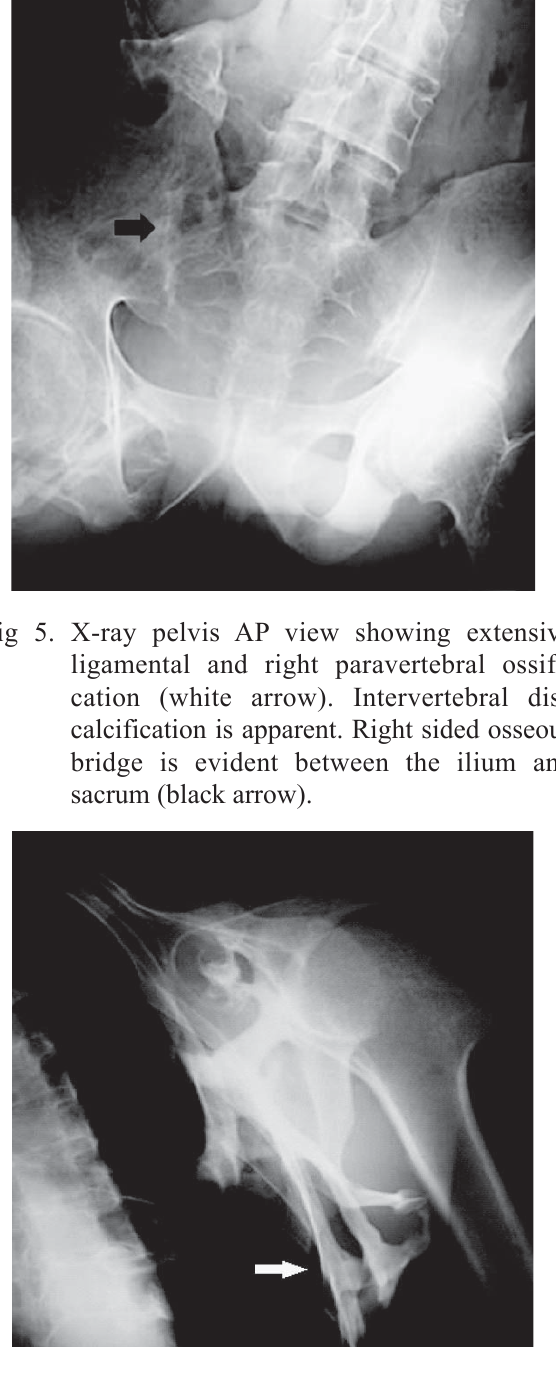
Fig 4. X-ray dorsal spine AP view showing scoliosis with convexity towards left. Orthotopic fusion of dorsal vertebra is seen. Pseudoexostoses with soft tissue ossification is evident (white arrow).